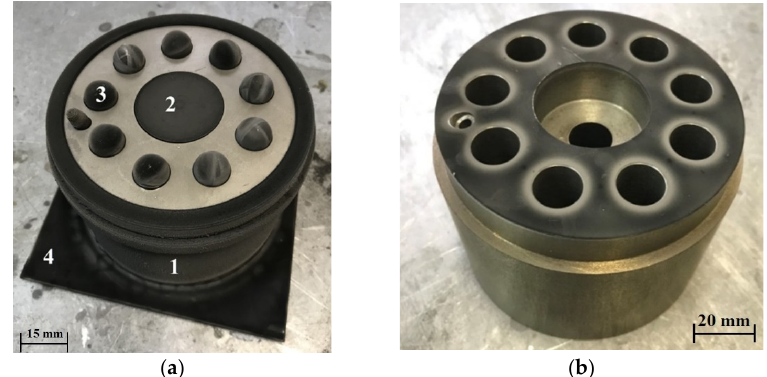
Figure 1. ( a ) Block blank in conventional tooling for ion-plasma nitriding; ( b ) block blank after ion-plasma nitriding (light gray zones with reduced hardness as a result of shielding from balls are clearly visible).